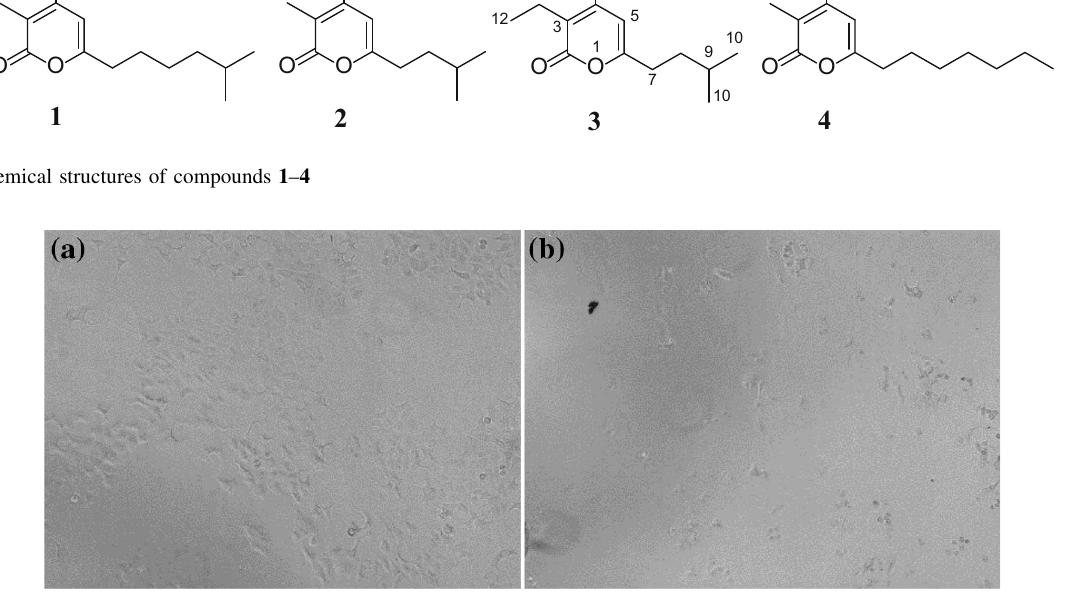
Fig. 2 Microscopic observation of MCF-7/TamR treated with DMSO ( a ) and KIB-H0495 extract ( b ) (10 mg/mL, 72